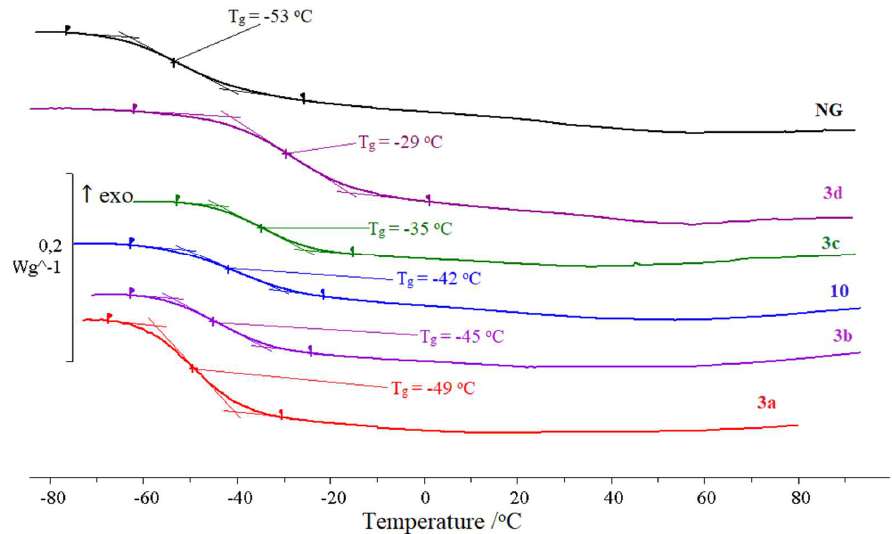
Figure 6. Low-temperature DSC profile of 50/50 NC /plasticizer compositions (ramp rate = 10 °C min −1 ).